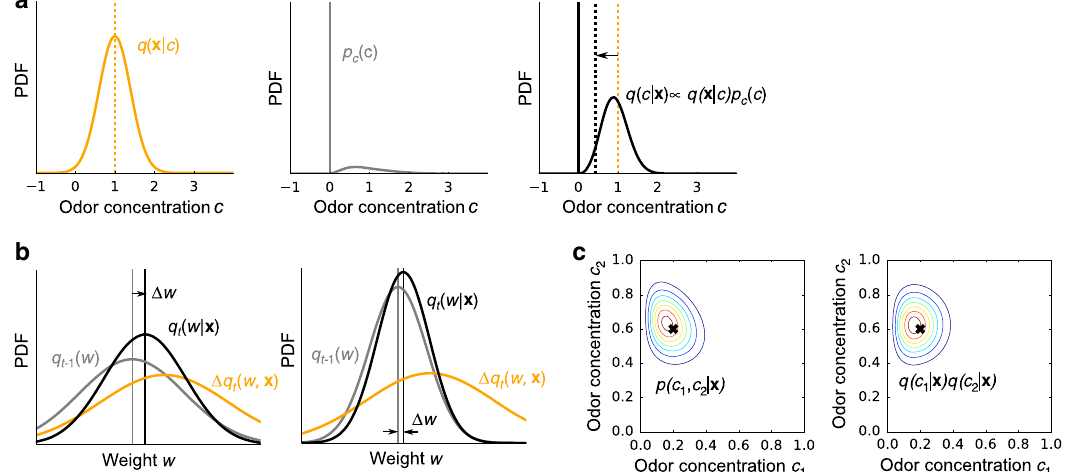
Fig. 2 Bayesian inference of odors and weights. a Inference of odor concentration. Combining the likelihood q ( x ∣ c ) (left) and the prior p c ( c ) (middle), the posterior distribution q ( c ∣ x ) is obtained (right). The orange dashed line is the mean concentration associated with the likelihood, q ( x ∣ c ); the black dashed line is the mean associated with the posterior, q ( c ∣ x ). Because the prior strongly favors the absence of odors, the latter is shifted to lower concentration. b Illustration of the weight update given the same sensory evidence Δ q t ( w , x ) when the previously estimated probability distribution over the weights, q t − 1 ( w ), is broad (left), and narrow (right). Note that the mean of q t − 1 ( w ) is the same in both panels. c Illustration of the variational approximation. The true posterior over the joint distribution of odors c 1 and c 2 , p ( c 1 , c 2 ∣ x ) (left), is approximated by a factorized distribution q ( c 1 ∣ x ) q ( c 2 ∣ x ) (right). The black cross indicates the true concentrations, and colored lines are contours of equal